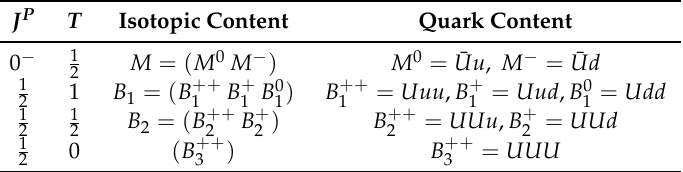
Table 3. Characteristics and quark content of new